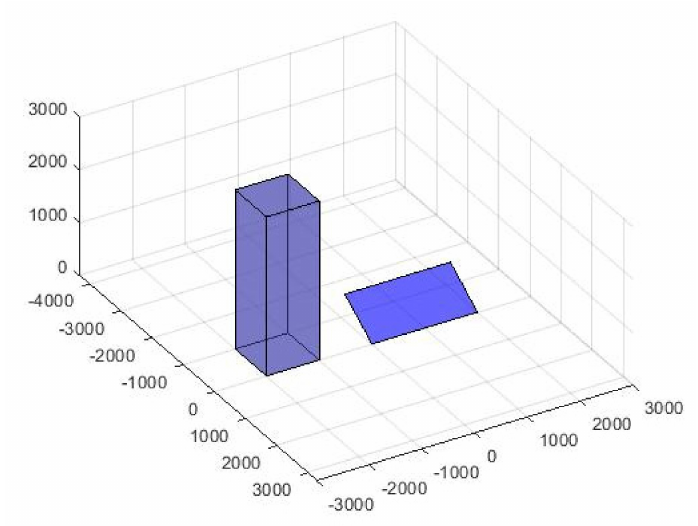
Figure 3. Visual output of one module with one obstacle generated in Matlab.